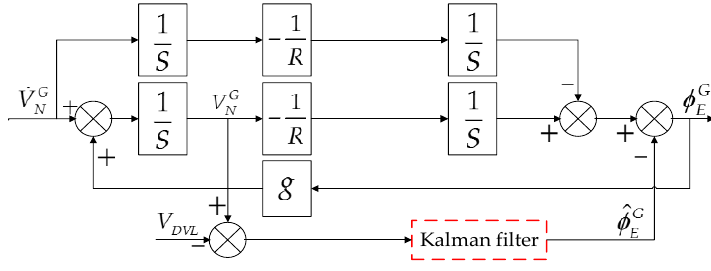
Figure 3. Block diagram of KF-DGSINS algorithm.